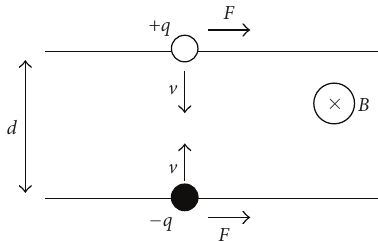
Figure 3: Schematic representaion of the e ff ect of a DC in-plane magnetic field on electrons and holes in a bilayer system with